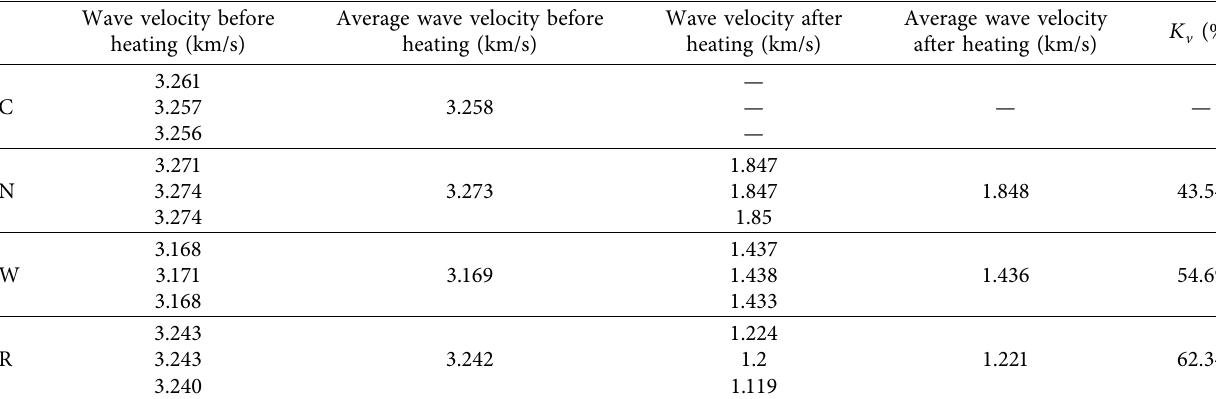
Table 2: Longitudinal wave